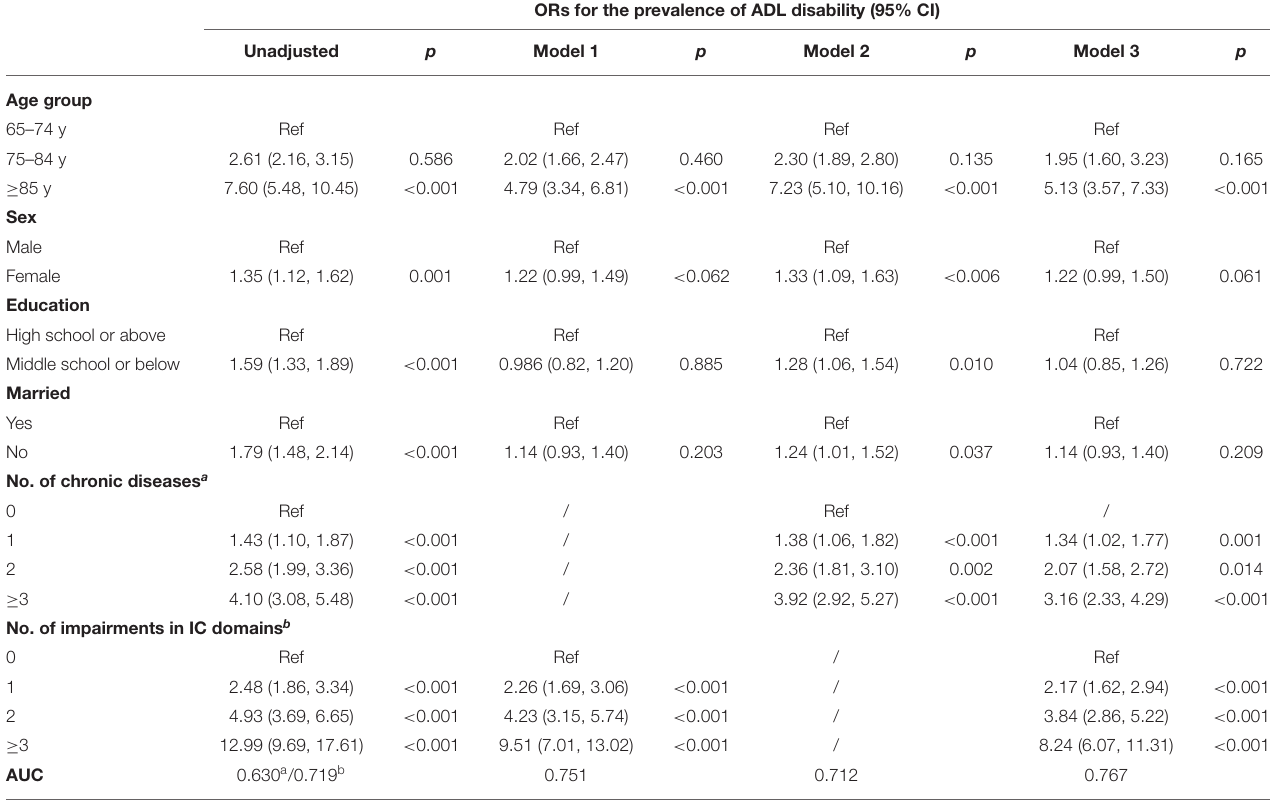
TABLE 3 | Logistic regression to determine the odds of activities of daily living (ADL) disability at baseline. ORs for the prevalence of ADL disability (95%